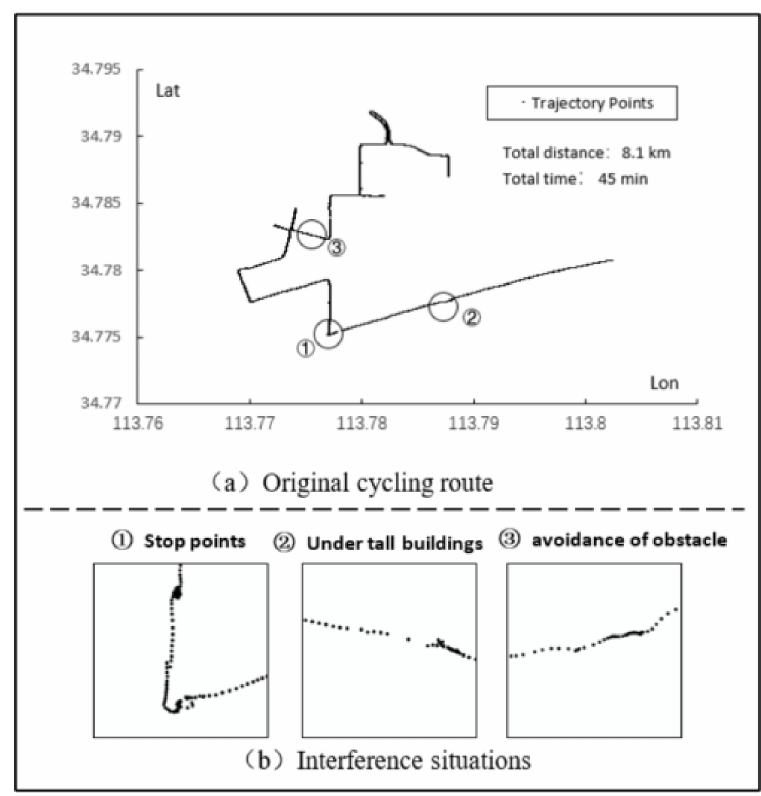
Figure 11. The third example of cycling trajectory.